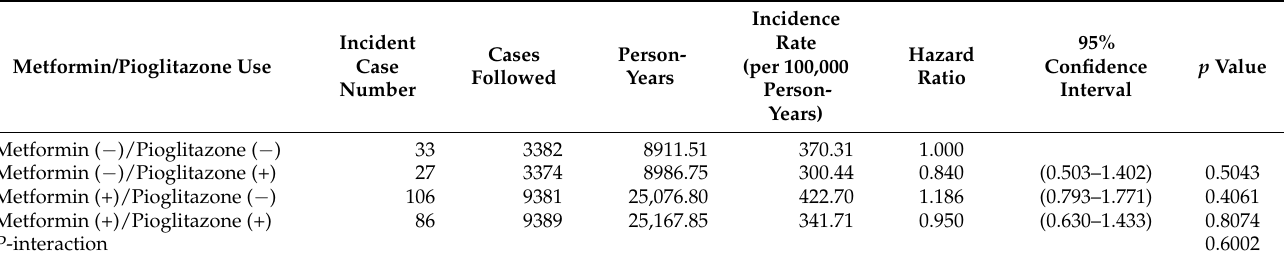
Table 4. Joint effect and interaction between metformin and pioglitazone on inflammatory bowel